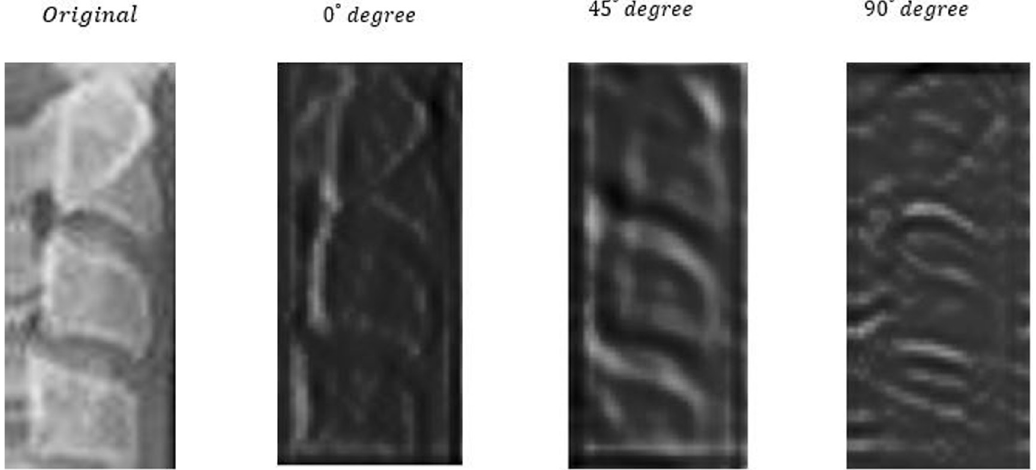
Fig 2. Effect of the directional filters on a ROI of a cervical vertebrae image (leftmost image). Outputs of 0˚, 45˚, and 90˚ filters are shown in the middle left, middle right, and the rightmost figures, respectively.